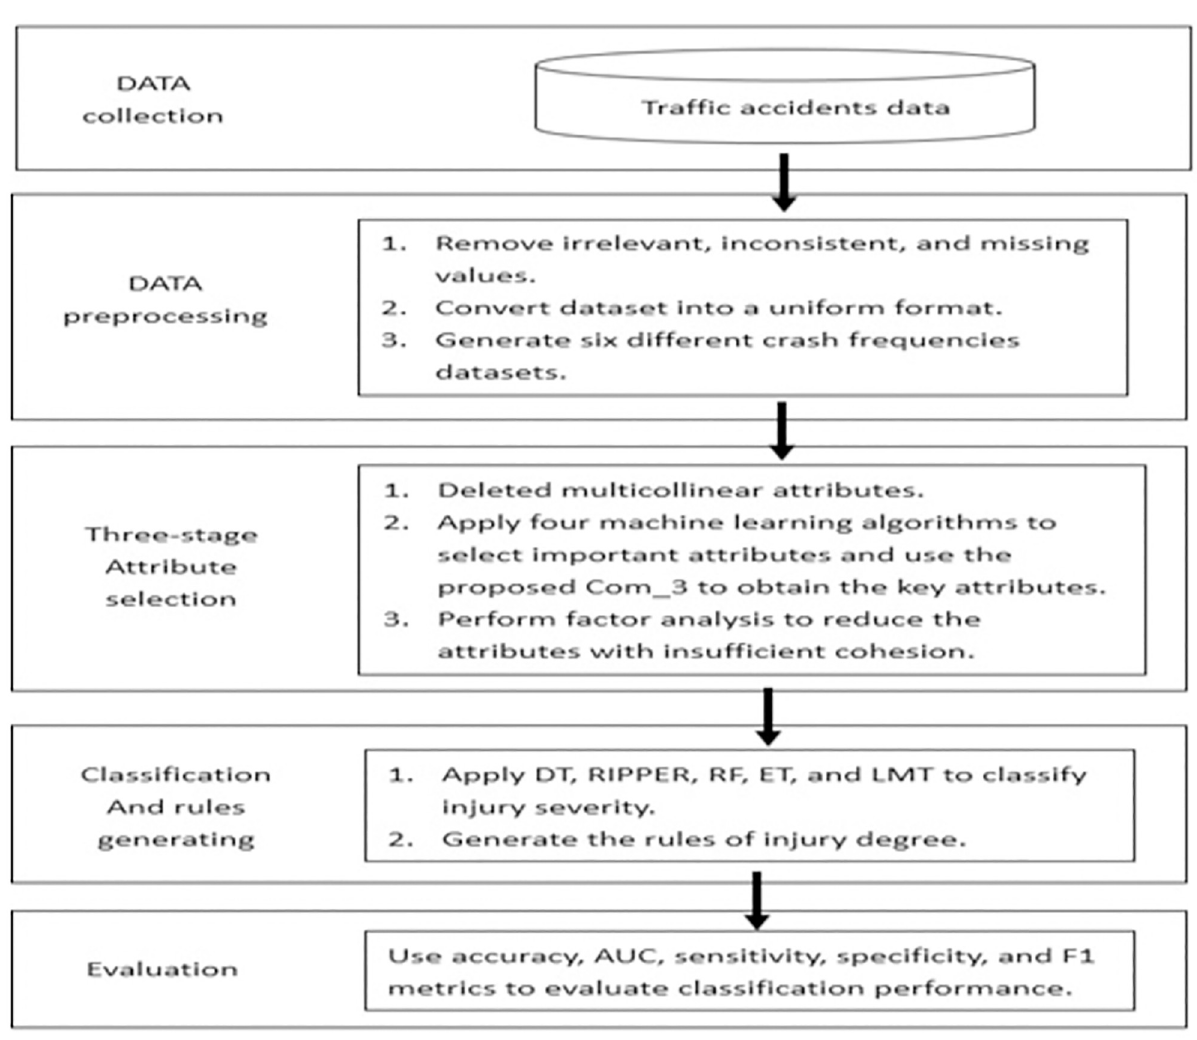
Fig 1. Proposed computational